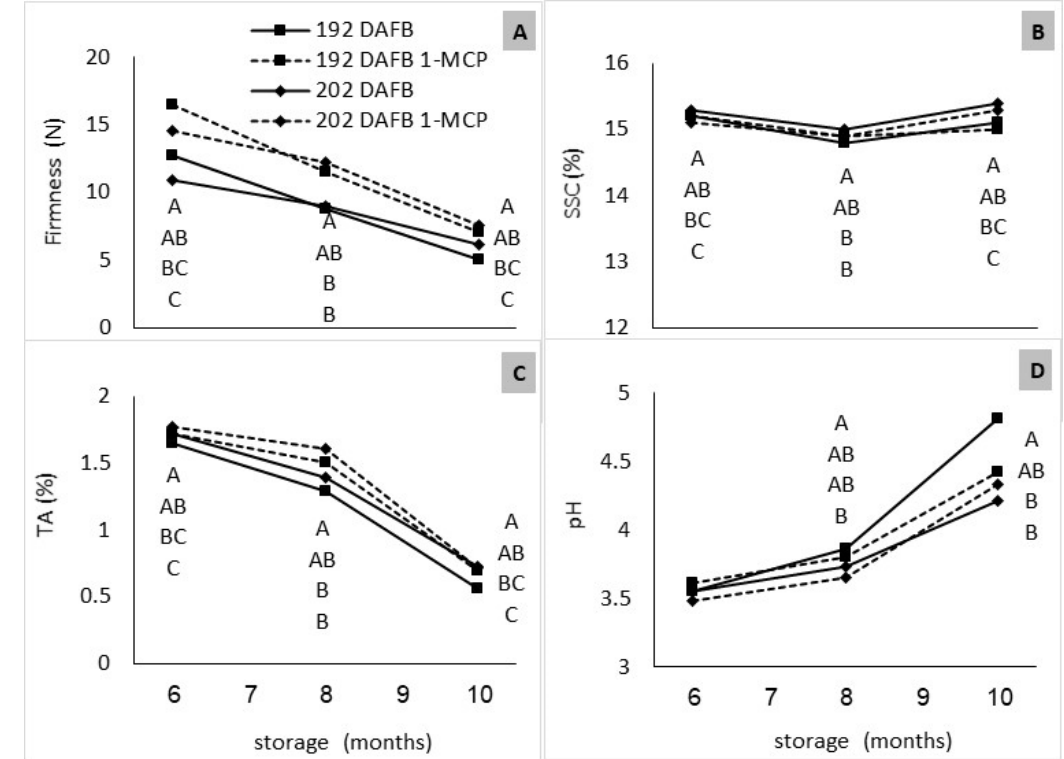
Figure 3. Effect of kiwifruit harvest time on changes in firmness ( A ), SSC ( B ), TA ( C ) and pH ( D ) during CA storage, with or without 1-MCP. The letters A–C represent significant differences at each month (Duncan p < 0.05).